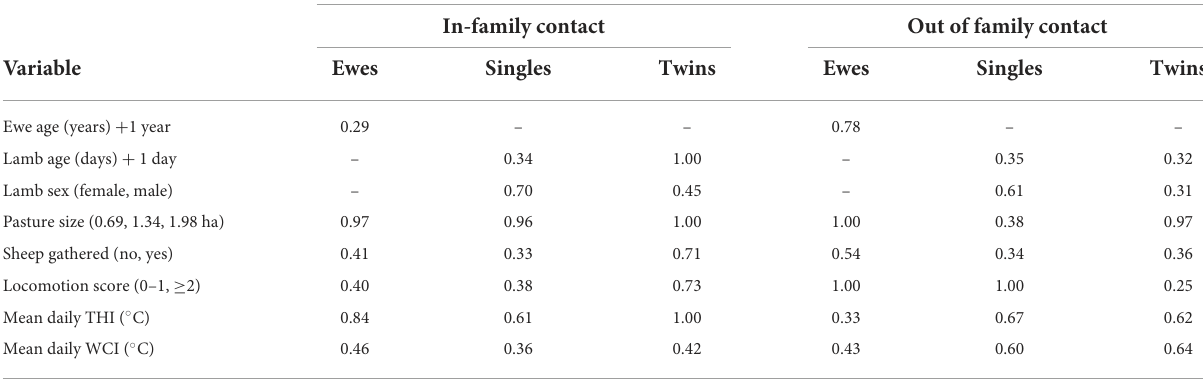
TABLE 7 Variable importance for variables in Table 6: factors associated with time ewes and lambs spent with their family and other sheep. Variable importance ( P Akaike Weight